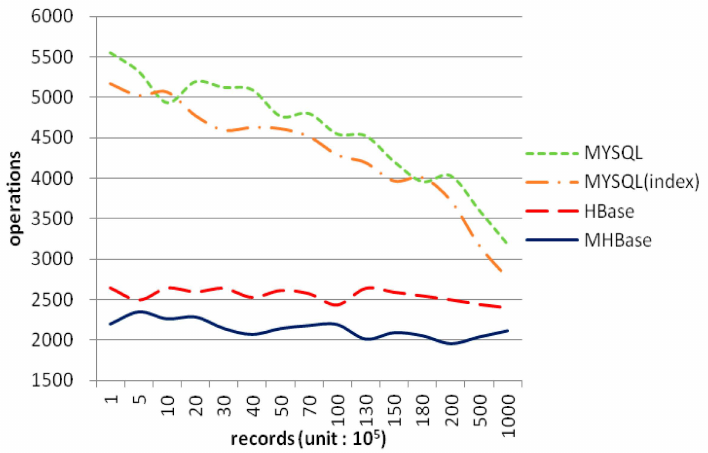
Figure 7. The time of data